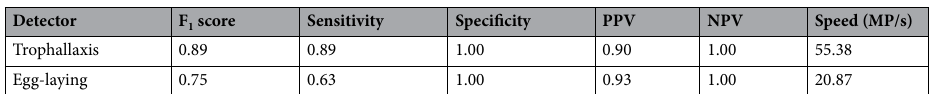
Table 1. Detailed detection and runtime performance estimates. Note that the runtime estimate for trophallaxis detection includes detecting the occurrence of trophallaxis as well as identifying the recipient. PPV positive predictive value, NPV negative predictive